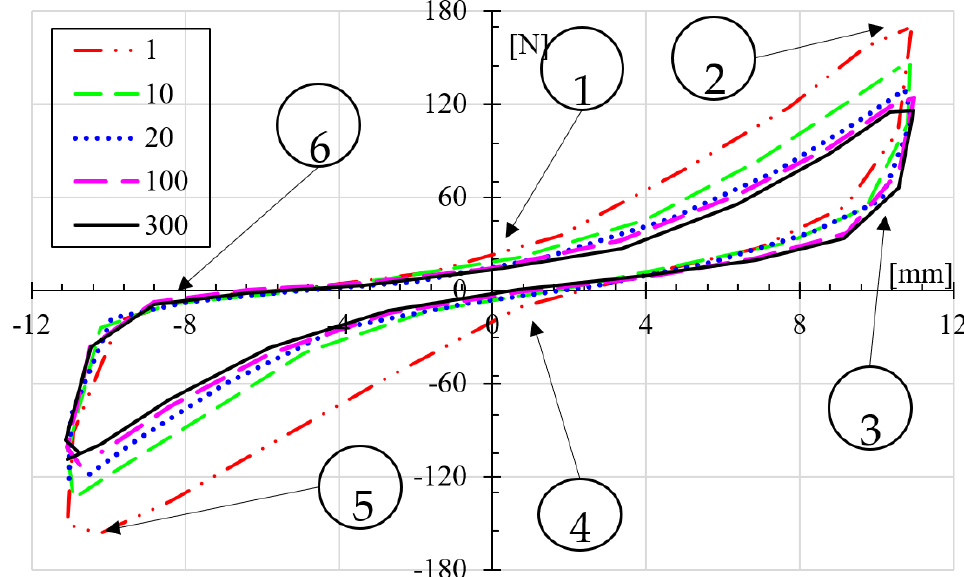
Figure 9. Exemplary load-displacement loops for a specimen subjected to ± 11 mm for different number of cycles .